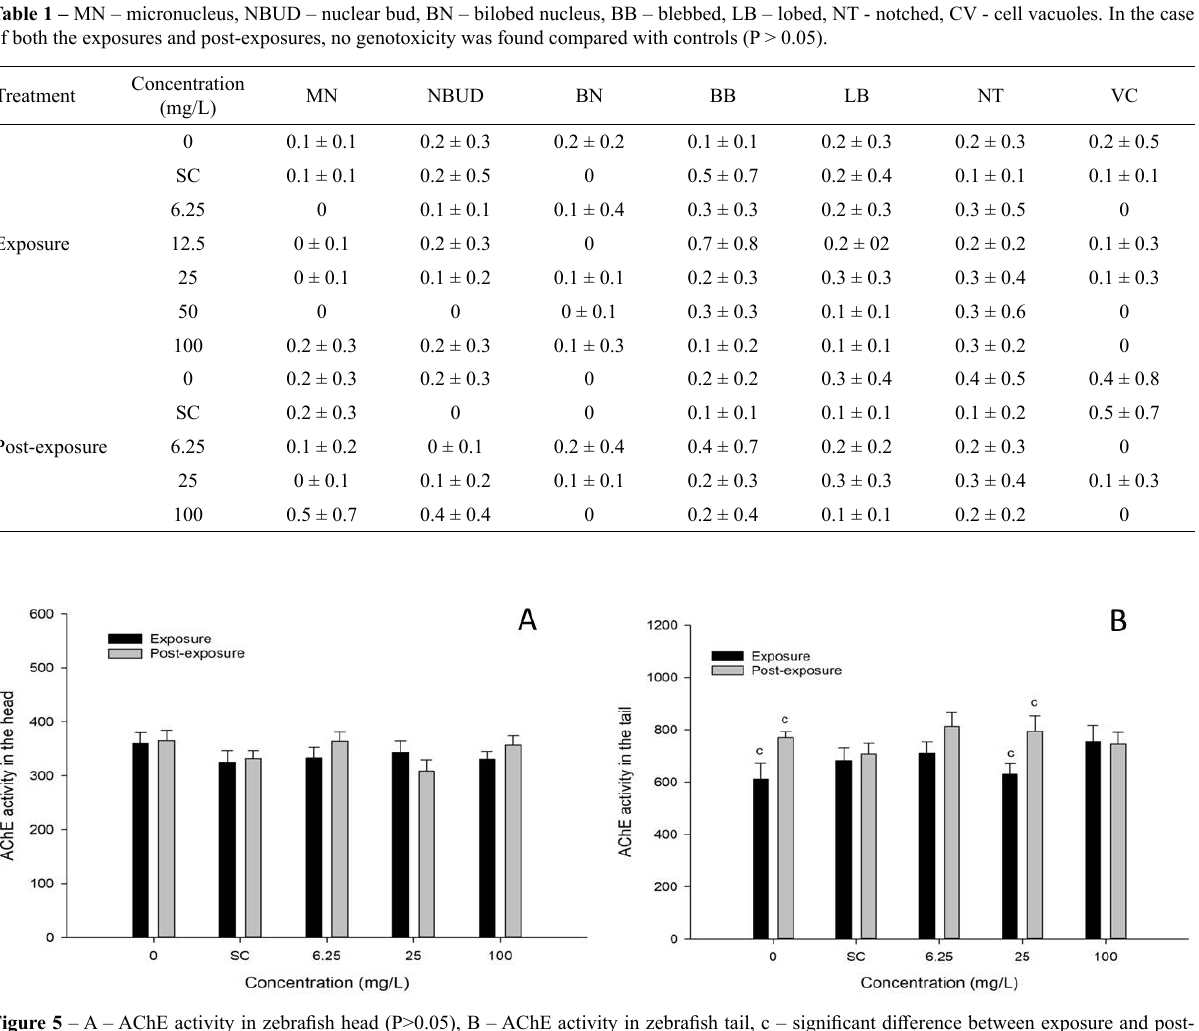
Figure 5 – A – AChE activity in zebrafish head (P>0.05), B – AChE activity in zebrafish tail, c – significant difference between exposure and post- exposure (P